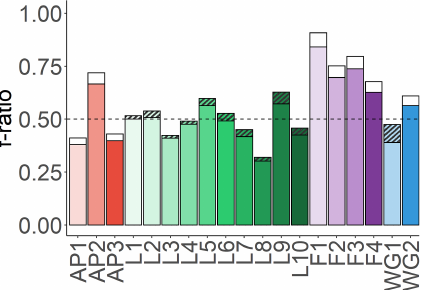
Figure 8. Euphotic-zone-integrated f ratios estimated for each sta- tion. The black-hatched and white bars show the difference be- tween the f ratio (excluding urea) (higher value, Eq. 4a) and the f ratio (including urea) (lower value, Eq. 4b), with the black-hatched bars indicating the stations where urea uptake was measured and the white bars indicating where it was estimated (see text for